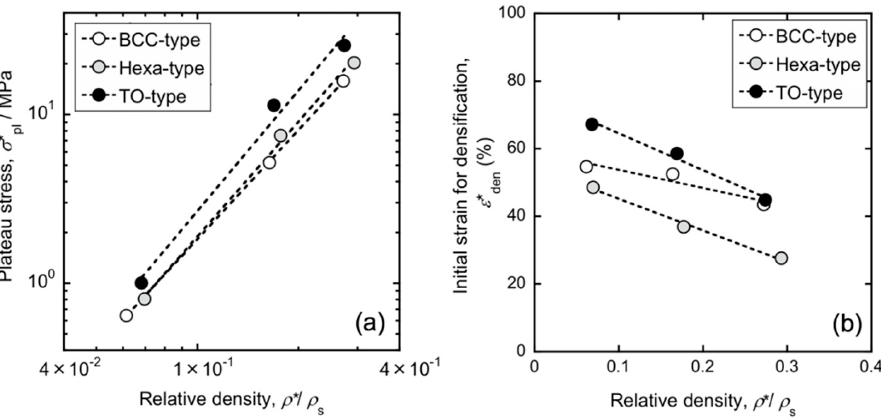
Figure 6. Changes in ( a ) plateau stress and ( b ) initial strain for densification as a function of relative density. Table 2. Constants for the BCC, TO, and Hexa lattice specimens in the Gibson-Ashby equation.